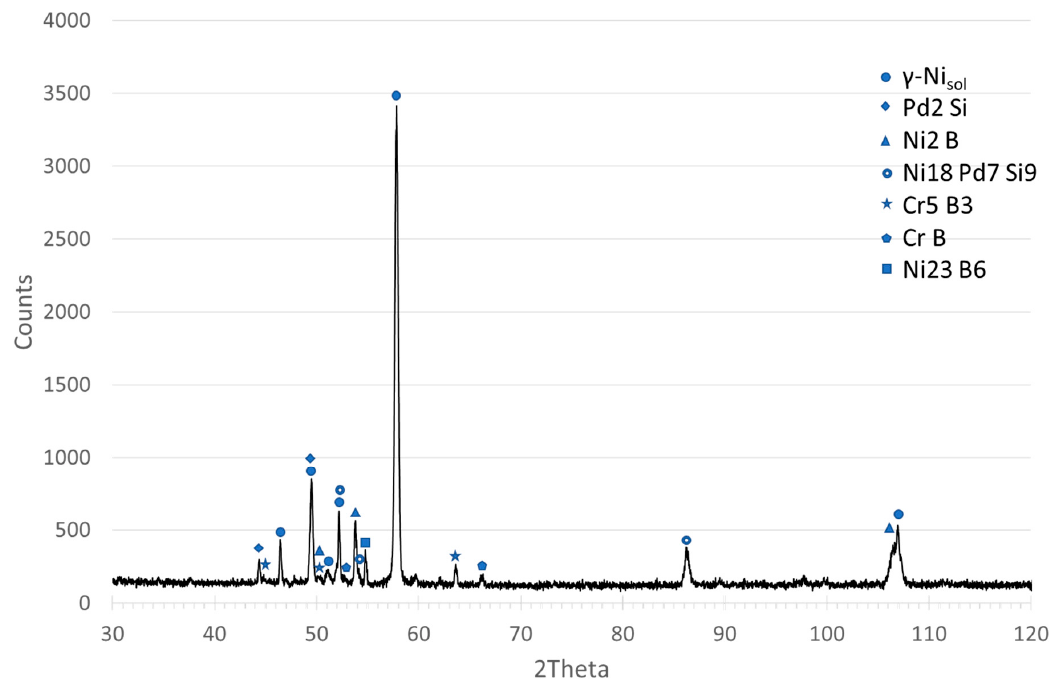
Figure 8. XRD patterns of MZ in Hastelloy X–Palnicro36 (Cobalt lamp WL—1.78897, counting time—5s, step—0.025 degrees).